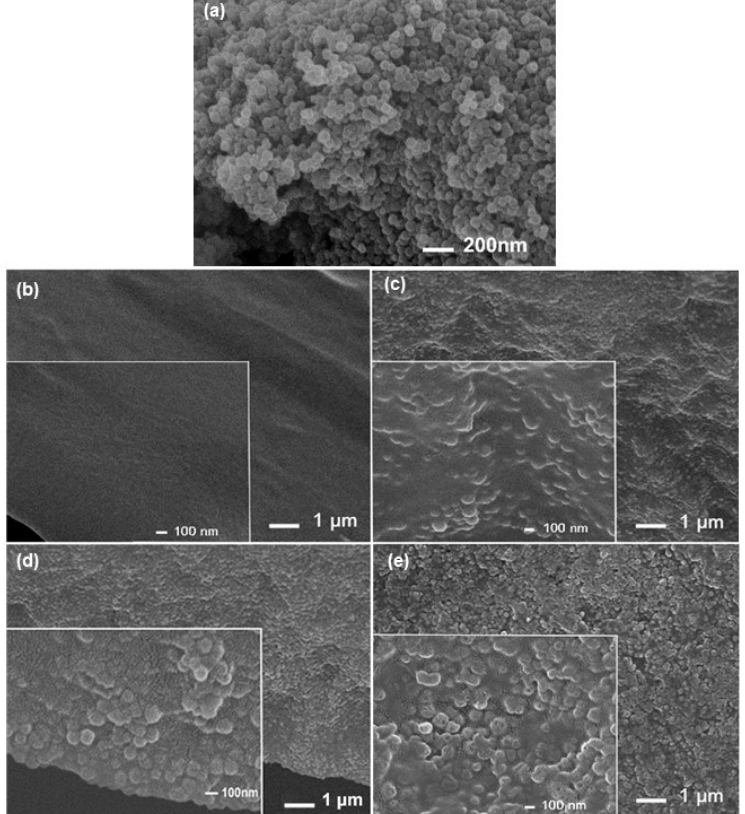
Figure 2. Field emission scanning electron microscope (FESEM) images of ( a ) ZIF-8 nanoparticles; and cross-sections of ( b ) pure PVA; ( c ) PVA/25.4% ZIF-8; ( d ) PVA/40.5% ZIF-8; and ( e ) PVA/45.4% ZIF-8